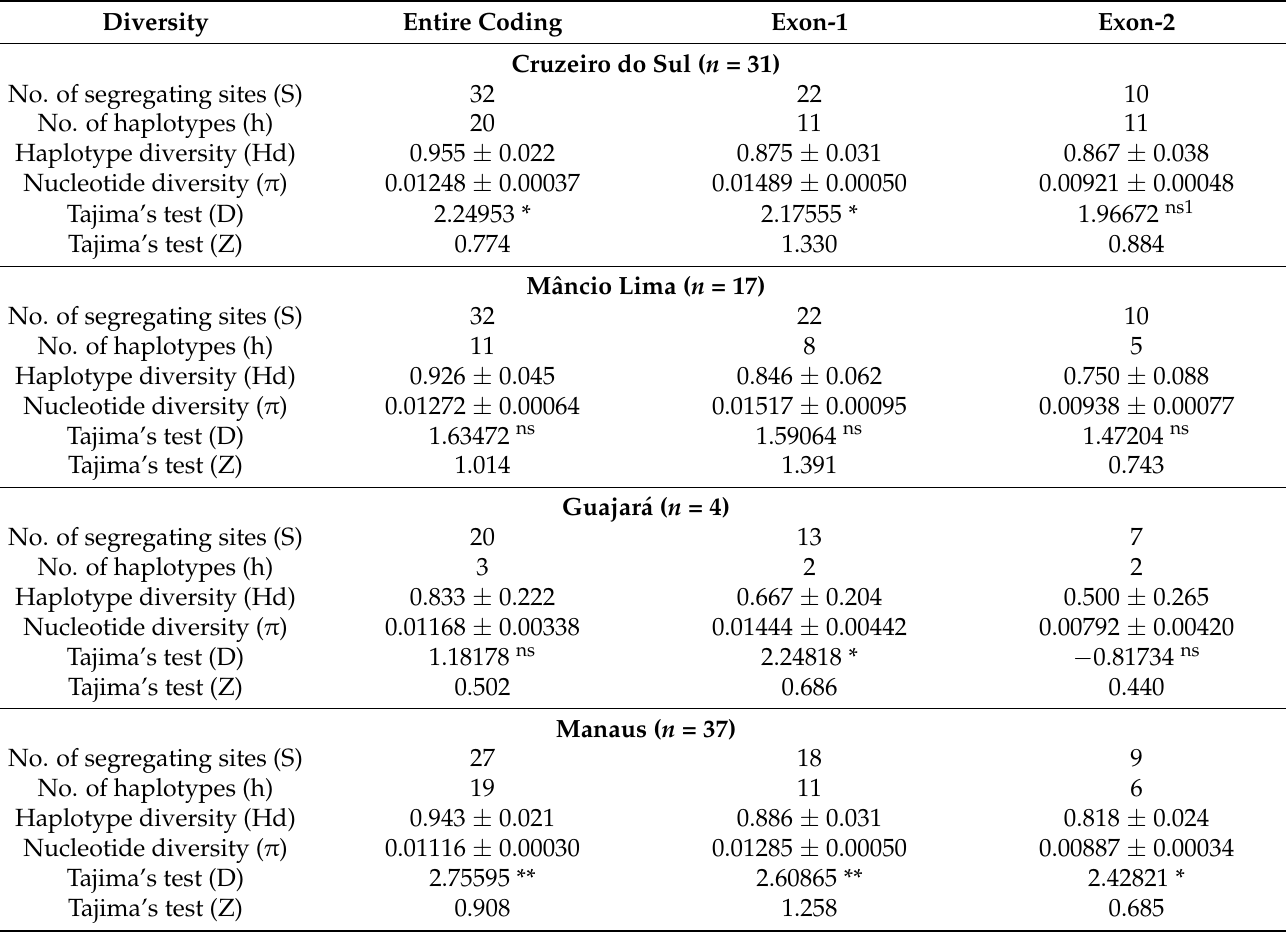
Table 3. Diversity parameters and natural selection for the pvcyrpa gene in P. vivax isolates from the Brazilian Amazon. Diversity Entire Coding Exon-1 Exon-2 Cruzeiro do Sul ( n =